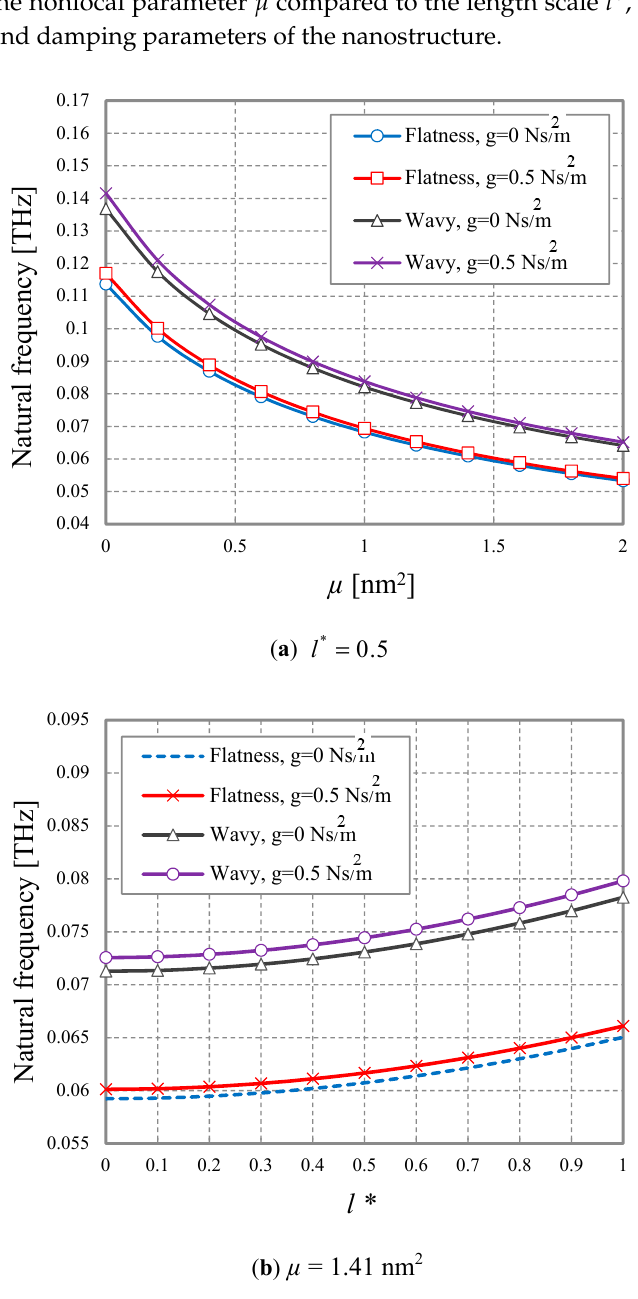
Figure 2. Variation of the natural frequency with the nonlocal parameter µ ( a ) and the length scale l ∗ ( b ).